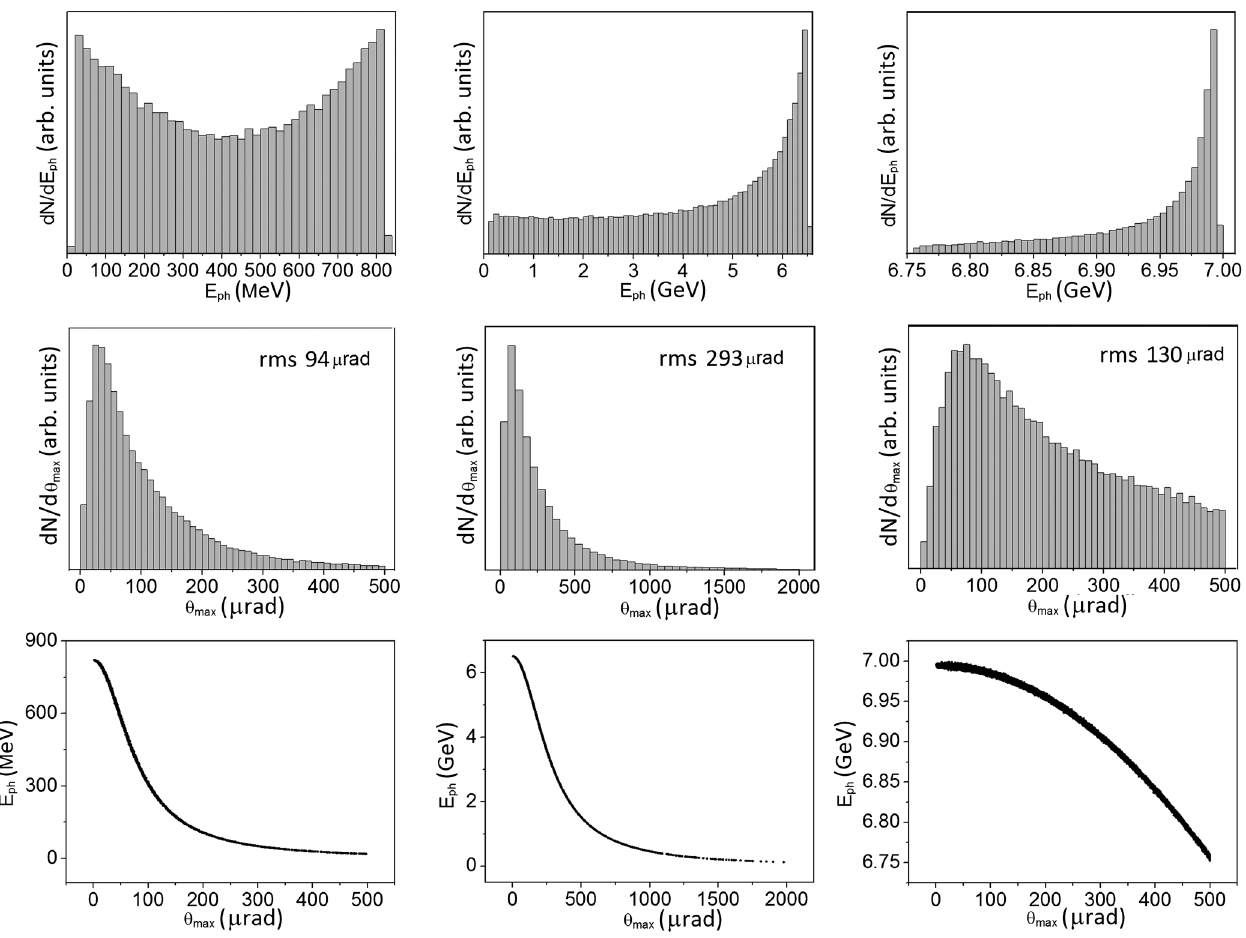
FIG. 5. Emitted photons features, CAIN simulations. First line spectrum, second line angular distribution, third line energy as a function of θ ( μ rad). Case D left column, case E middle column, case F right max